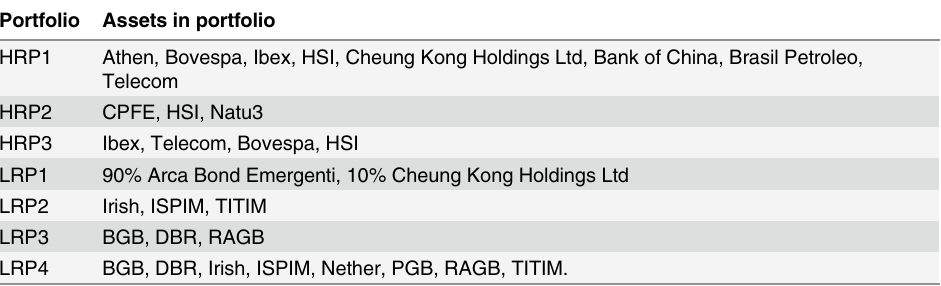
Table 2. Portfolios composition.